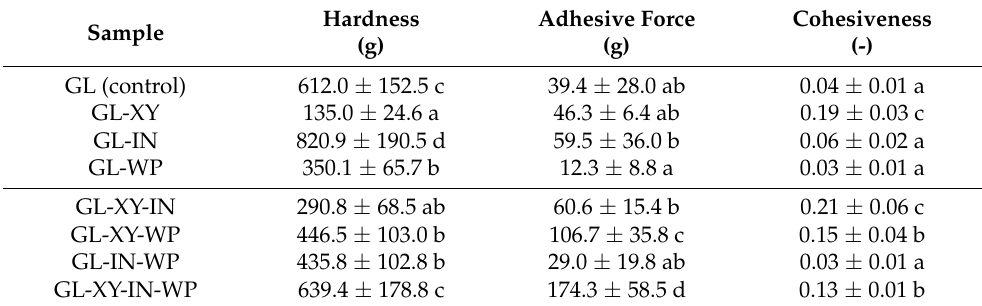
Table 6. Textural properties of green lentil cookies.